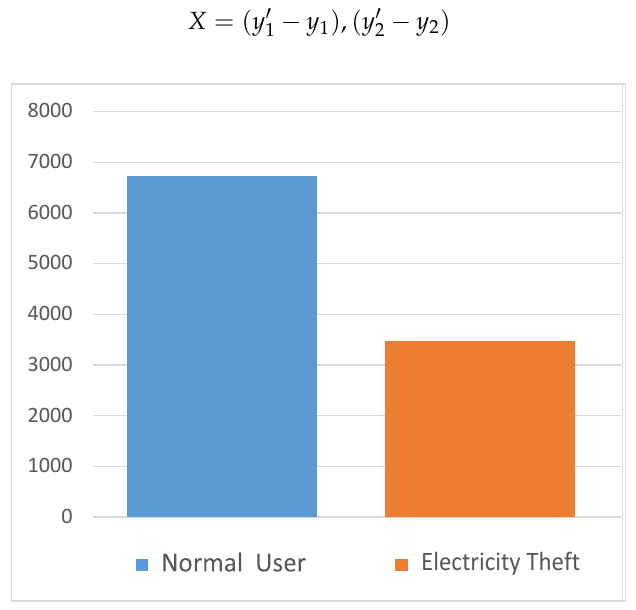
Figure 4. Normal data.